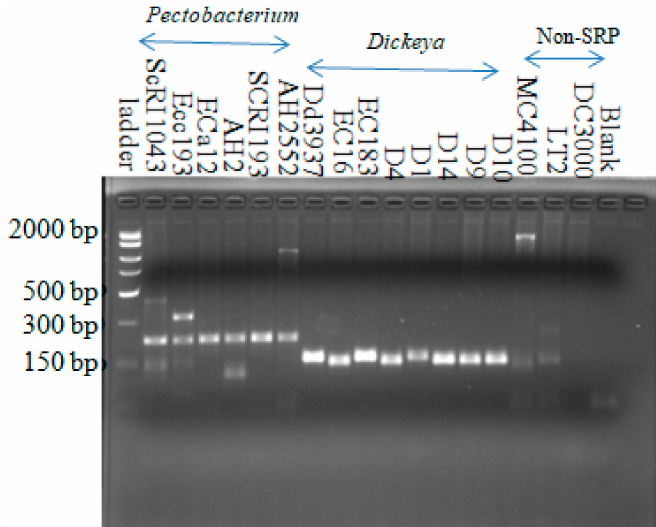
Figure 3. Amplification from all Dickeya strains with the Dickeya -specific primer set (Dda1F-Dda1R). The product size is around the expected size of 157 bp. Six Pectobacterium strains generated about 220-bp bands. Three others, two Enterobacteriaceae (MC4100 and LT2), and Pseudomonas syringae (DC3000) strains did not show the 157-bp bands. Fifteen-microliter reactions were carried out in 45 cycles with annealing at 56.6 ◦ C for 1 min and an extension at 72 ◦ C for 1